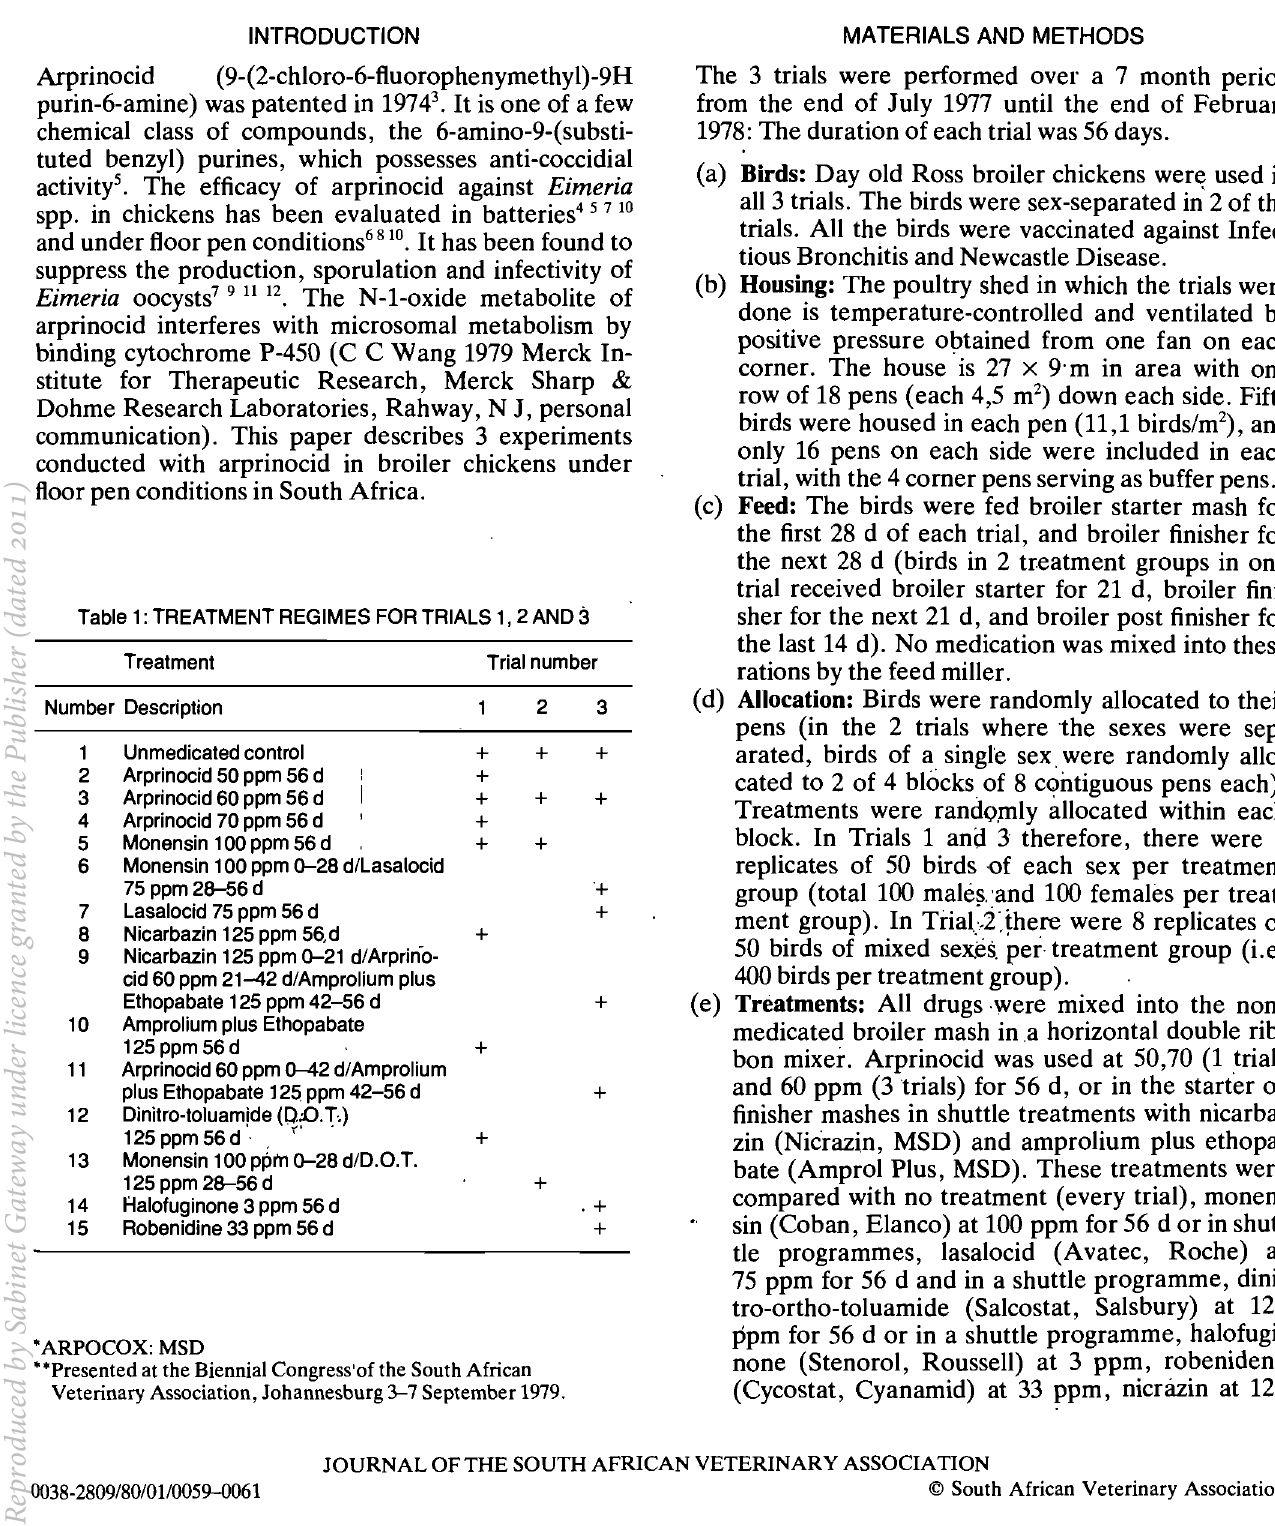
Table 1: TREATMENT REGIMES FOR TRIALS 1,2 AND 3